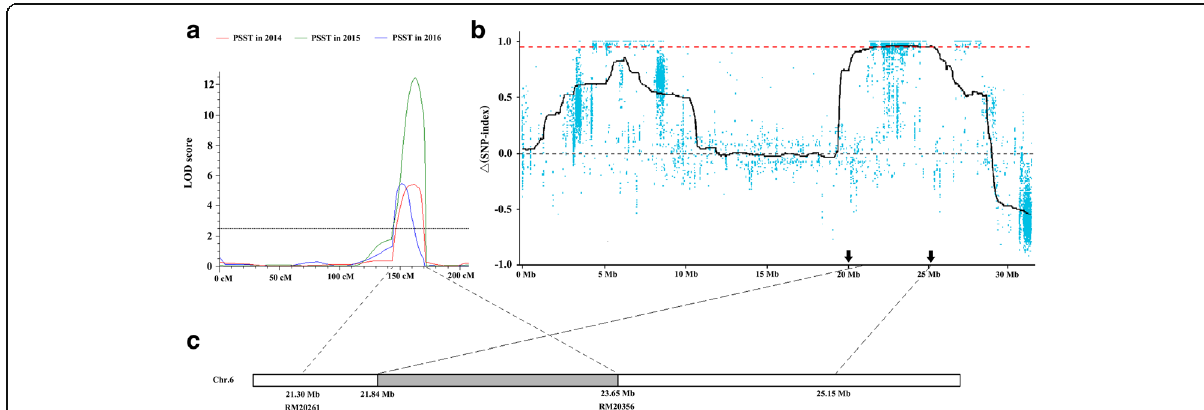
Fig. 4 Mapping of qPSST6 on chromosome 6 using the methods of QTL analysis and Seq-BSA. a: qPSST6 detected in the RIL population by using the ICIM module of QTL IciMapping 3.2. The LOD scores are shown with three distinct peaks corresponding to qPSST6 in 2014, 2015 and 2016, respectively. b: hot-region for PSST identified by SNP-index method on chromosome 6. The black line shows the Δ (SNP-index) value of fitting results. The red dotted line shows the association threshold value (0.9532), and the black arrows on the x-axis represent the location of hot-region for PSST. c: the intersection of qPSST6 interval identified by QTL analysis and Seq-BSA. The gray region on the chromosome shows the 1.81 Mb intersection of qPSST6